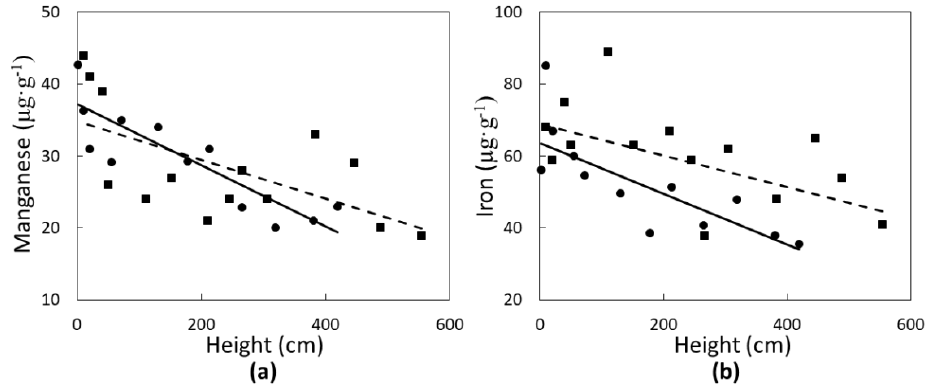
Figure 3. The influence of Cycas micronesica tree height on ( a ) manganese and ( b ) iron green leaf concentration in Rota (squares and dashed line) and Yap (circles and solid line).